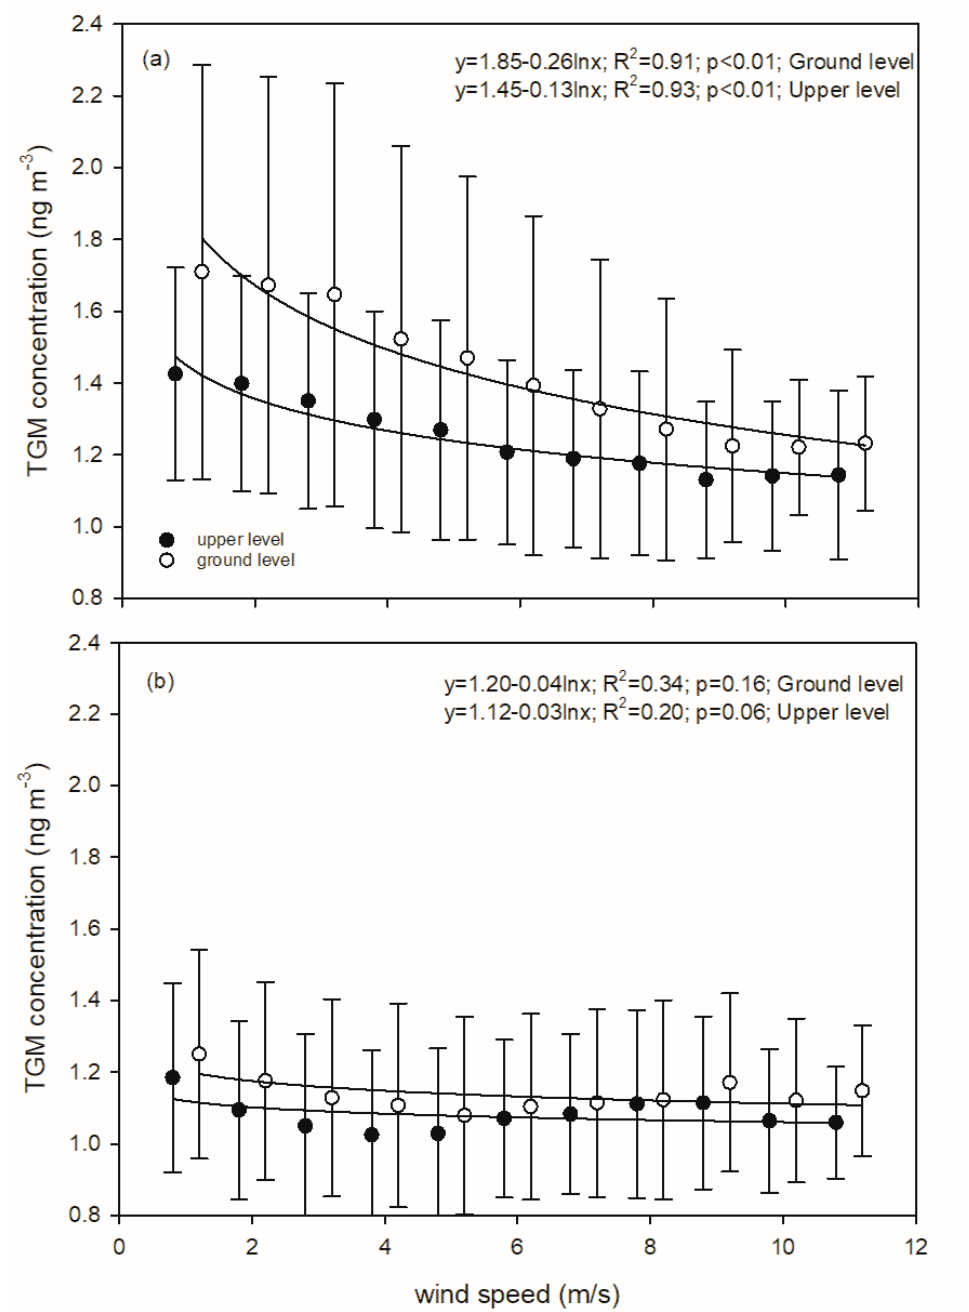
Figure 6. Comparison of the relationship of TGM concentrations with wind speed at the two heights prior to ( a ) and after ( b ) brownfield remediation at the Syracuse CoE.